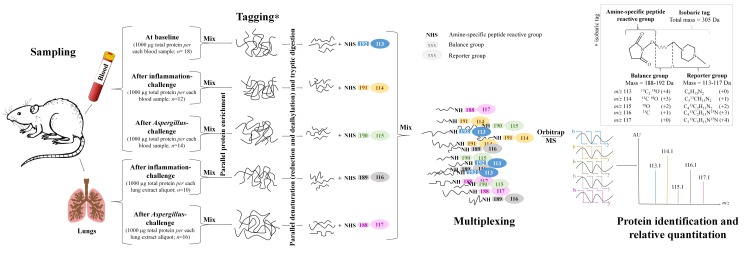
Example of study design for iTRAQ® protocol in the experimental rat model of invasive aspergillosis.Upper right panel, the iTRAQ® reagent is designed as an isobaric stable tag consisting in a charged reporter group that retains charge (N,N-dimethylpiperazine), a peptide reactive group (N-hydoxy-succinimide) that is amide-linked to the N-terminus and the ε-amino side chains of all the peptides got from prior tryptic digestion, and a neutral balance portion (carbonyl) to maintain an overall mass of 305 kDa by the means of differential isotopic enrichment with 13C, 15N and 18O atoms [33]. The selection of the reporter region in the low mass area enables keeping the additive mass to the fragments as negligible as possible in order to minimize any side effect during chromatographic separation and to avoid any interference with other fragment ions during mass spectrometry analysis, thus allowing for the highest degree of confidence; Main panel, after intra-tracheal challenge with bacterial lipopolysaccharides (LPS) or Aspergillus fumigatus conidia, rat samples were pooled according to their clinical status: healthy controls at baseline before intra-tracheal challenge in blood, non-Aspergillus inflammatory controls and Aspergillus-diseased cases, both in blood and in lung parenchyma for the last two groups [19,20]. Overabundant proteins, like albumin and immunoglobulins, were removed through a commercial kit before mass spectrometry analysis [23,56], and specific labelling with individuals tags, ranging from 113-iTRAQ® to 117-iTRAQ® reagents, was then applied to each pooled aliquot [16]. The reporter-balance peptides remained intact, so that for one given common protein, the five multiplexed rat samples had an identical m/z: the peptide fragments were equal, only the reporter ions were different. Indeed, the precursor ions, and all the internal fragment ions, i.e. type b- and y-ions respectively, contain all five members of the tag set, but remain isobaric, i.e. the five species have the same atomic mass but different arrangements. After collision in the QExactive® Orbitrap mass spectrometry (MS) instrument, the five reporter group ions appeared as distinct masses ranging between m/z 113–117, while the remainder of the sequence-informative b- and–y ions remain isobaric and their individual current signal intensities were additive. The relative concentration of the peptides in every samples pool was then deduced from the relative signal intensities of the corresponding reporter ions. Protein identification was achieved by comparison of the peptide sequences with Specific SwissProt® reviewed non-redundant database (http://www.uniprot.org/uniprot/) of Rattus norvegicus (rat) proteome using the Sequest® HT search engine (Washington DC, U.S.A.). Abbreviations: b-ion, Precursor ion; C, Carbon; Da, Dalton; MS, Mass spectrometry; m/z, Mass-to-charge ratio; O, Oxygen; N, Azote; y-ion, Internal ion; U.S.A., United States of America.